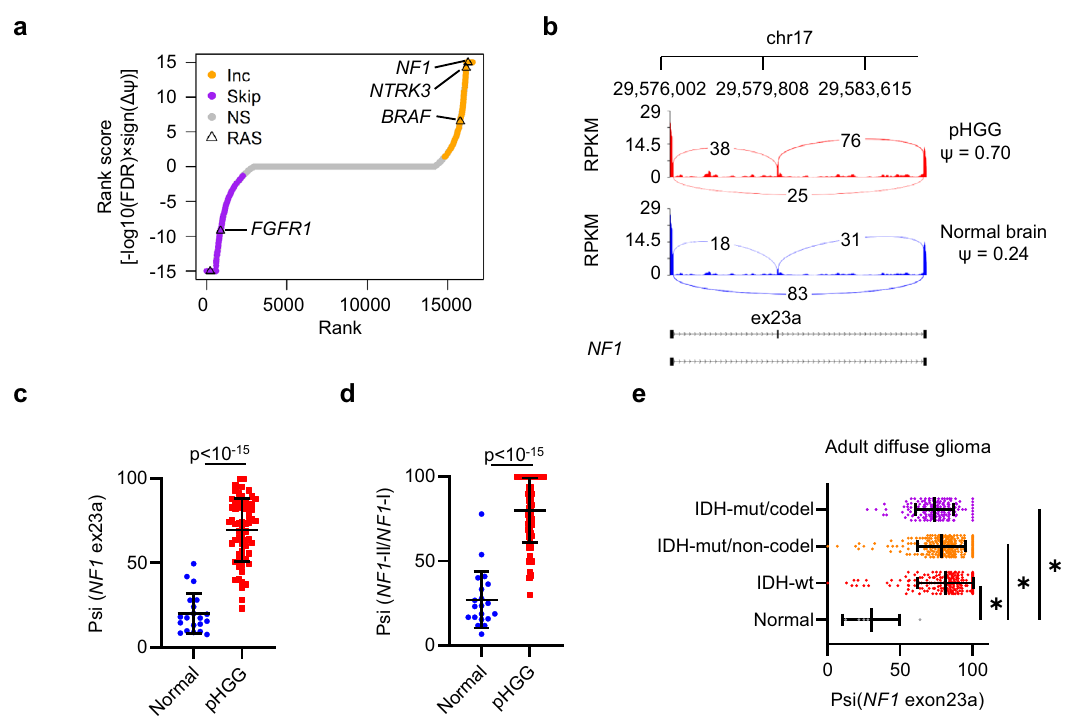
Fig. 4 Alternative splicing of NF1 exon23a in HGG. a Genes were ranked according to their most signi fi cant splicing score. Signi fi cance is shown by point color (orange, inclusion [Inc]; purple, skipping; NS not signi fi cant). RAS/MAPK pathway genes with signi fi cant differential ASE (ASE; | Δψ | >0.15, FDR < 0.05) are marked. b Sashimi plot showing average reads per kilobase per million (RPKM) in pHGG and normal brain for coverage of the NF1 exon23a skipped exon and immediate up- and downstream exons. c NF1 exon23a percent inclusion (psi) in pHGG ( n = 64) and normal brain ( n = 20) as